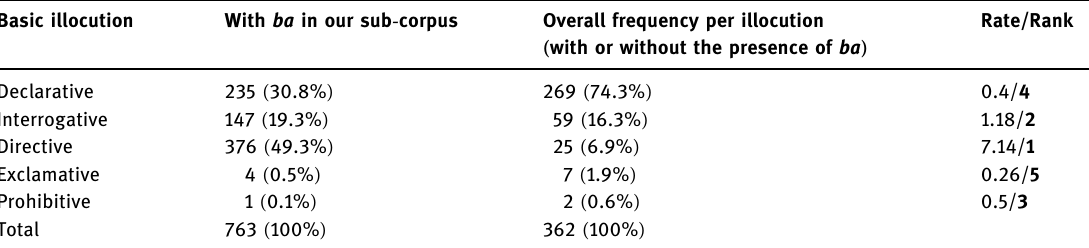
Table 2: Frequency and percentage of basic